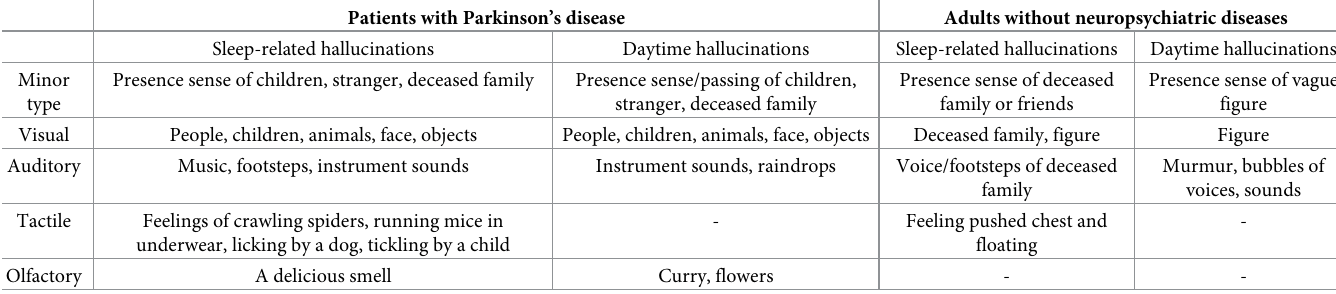
Table 6. Descriptions of hallucinations in patients with Parkinson’s disease and